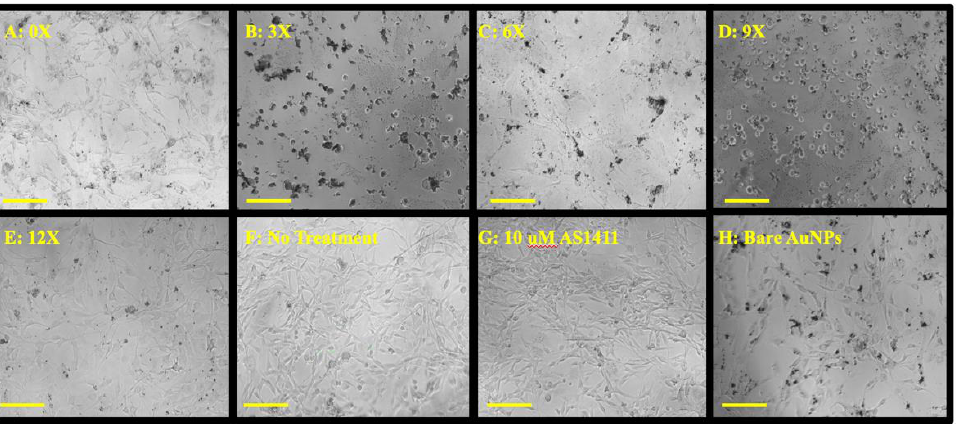
Figure 6. Morphological effects on U87MGs from treatment with co-conjugated PEG-AS1411 4 nm GNPs. Panels ( A – E ) represent 1 µ M treatment groups. Panels ( F – H ) represent control groups. The scale bar indicates 100 microns.